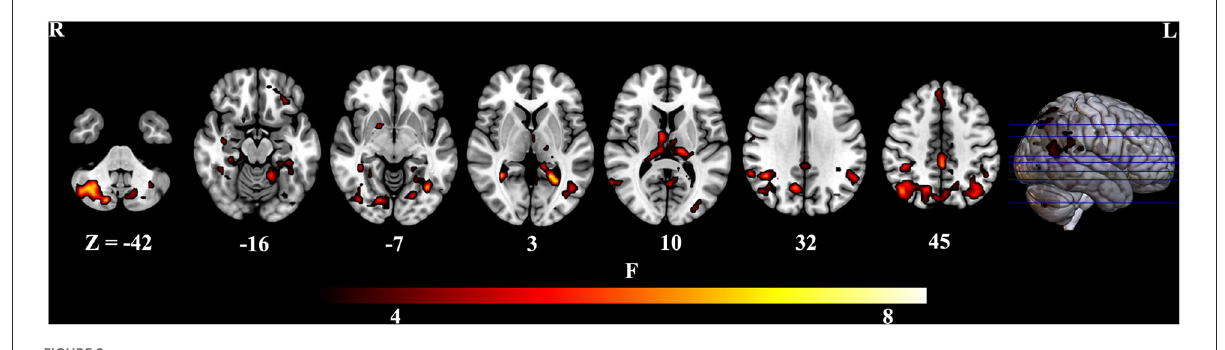
FIGURE2 Brain regions contributing to altered global FCD.